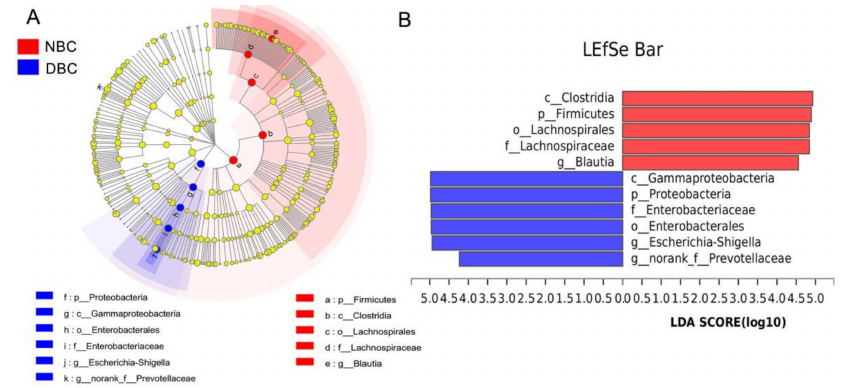
Figure 4. Differentiated microbes between depressed and non-depressed breast cancer patients. ( A ) LEfSe analysis was used to distinguish the differential microbes between the DBC and NBC patients. The different colored nodes represent microbial populations that were significantly enriched in the corresponding groups and that showed significant differences between the groups. ( B ) LDA was performed, and only the microbiota with LDA scores of > 4 are shown. DBC, depressed breast cancer patients ( n = 18); NBC, non-depressed breast cancer patients ( n = 37).